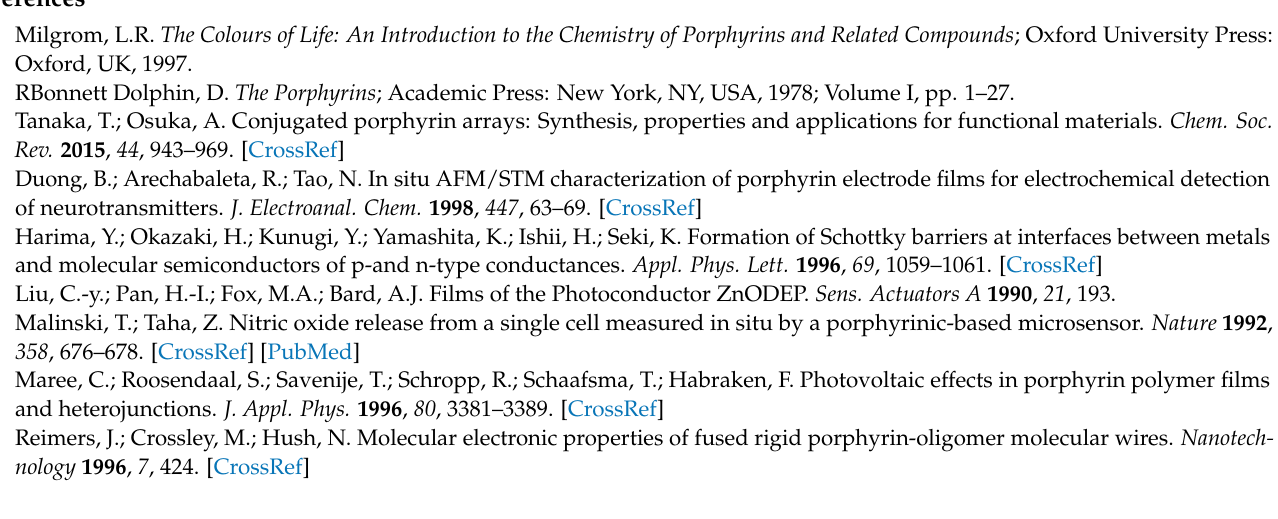
CHCl3; Figure S5. Characterization of porphyrin molecule 1b. (a) 1H-NMR spectrum in CDCl3, (b) Mass Spectrum, (c) UV-visible spectrum in CHCl3; Figure S6. Characterization of porphyrin Figure S7. Characterization of porphyrin molecule 1d. (a) 1H-NMR spectrum in CDCl3, (b) Mass Spectrum, (c) UV-visible spectrum in CHCl3; Figure S8. Characterization of porphyrin molecule 1e. (a) 1H-NMR spectrum in CDCl3, (b) Mass Spectrum, (c) UV-visible spectrum in CHCl3; Figure S9. Sample preparation of porphyrin polymer for AFM measurements using (a) simple drop-casting technique, (b) two-bottle soaking method; Figure S10. Histograms show the height of porphyrin polymer (over-900 mer) assembled on HOPG surface; Figure S11. Characterization of